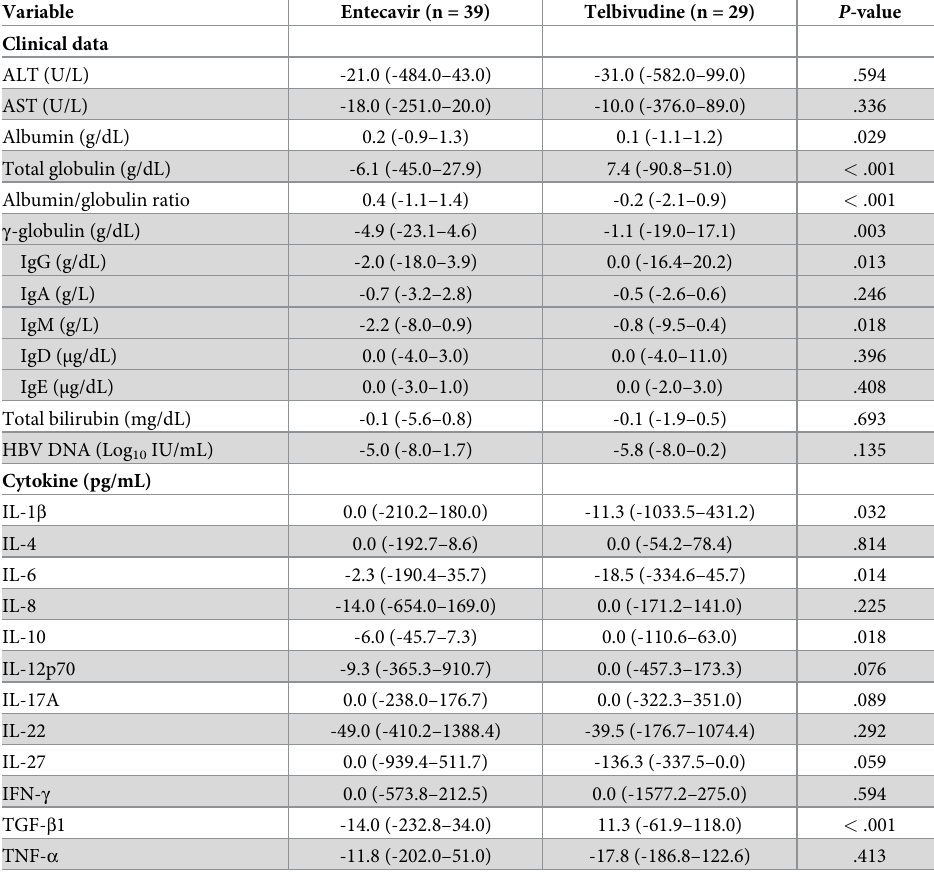
Table 2. Changes in levels ( Δ ) of factors after 48 weeks of treatment in patients with HBV-related liver cirrhosis.